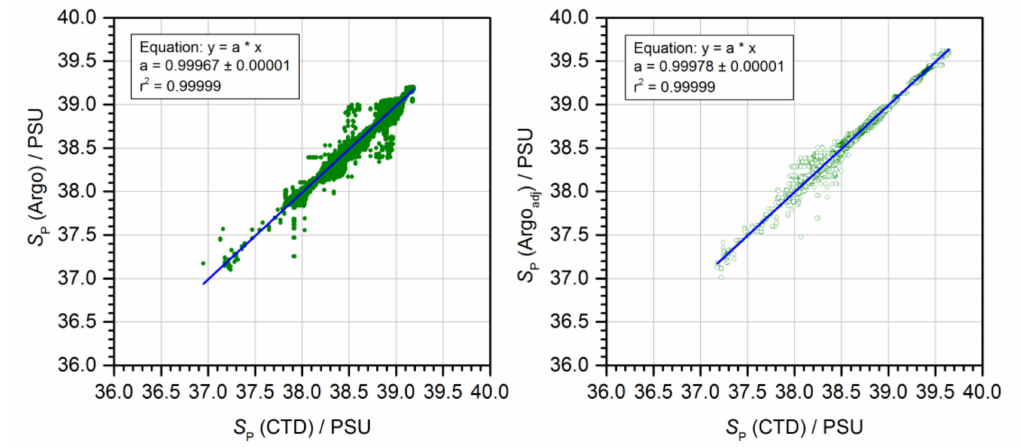
Figure 19. Scatter diagram and linear regression (slope a , coe ffi cient of determination r 2 ) of Argo (not-adjusted, left , and adjusted, right ) vs. CTD values: salinity (all data in the water